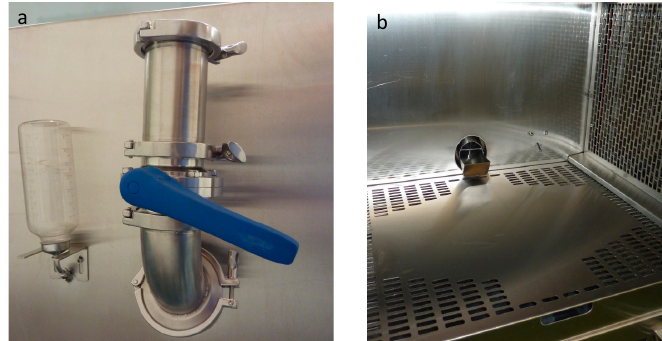
Figure 4. Feeder and water bottle. ( a ) Outside view of the feeder with butterfly valve and water bottle installed on a cage, ( b ) cage inside view with feeder, animal water supply and excreta pan.